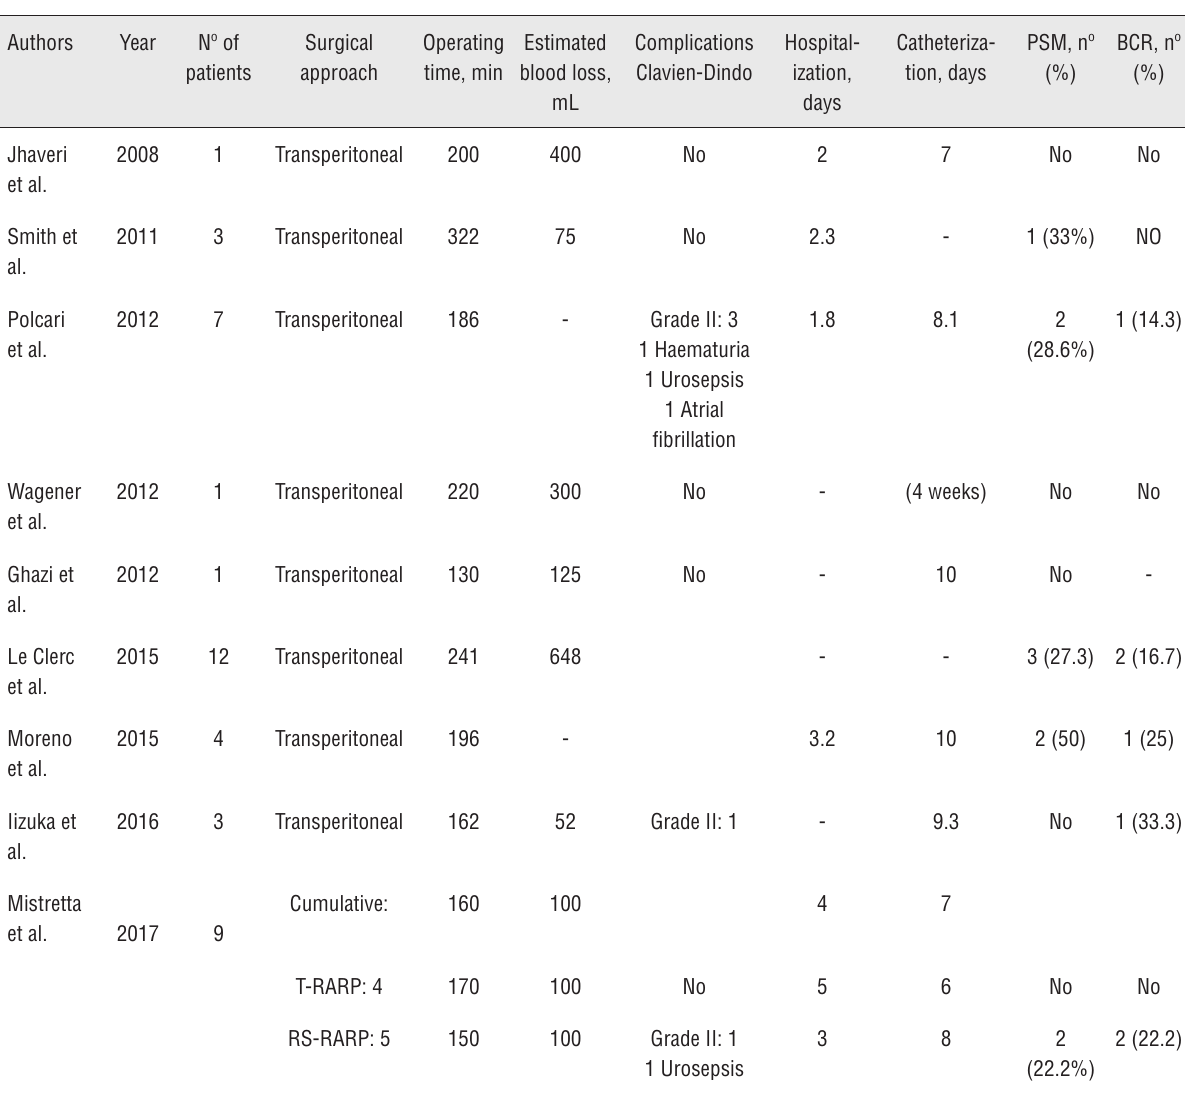
Table 3-Overall survival Kaplan-Meier curve